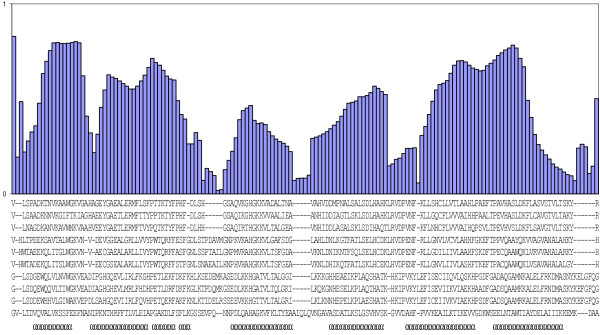
Maximum posterior decoding alignment, and column reliabilities. The maximum posterior decoding alignment of ten globins (human, chicken and turtle alpha hemoglobin, beta hemoglobin, myoglobin and bean leghemoglobin). Posterior probabilities for aligned columns were estimated as their rate in the Markov chain. Common alpha helices are indicated with 'α' symbols under the alignment. A broad correspondence between peaks in the posterior alignment reliability and the position of conserved secondary structure is apparent.